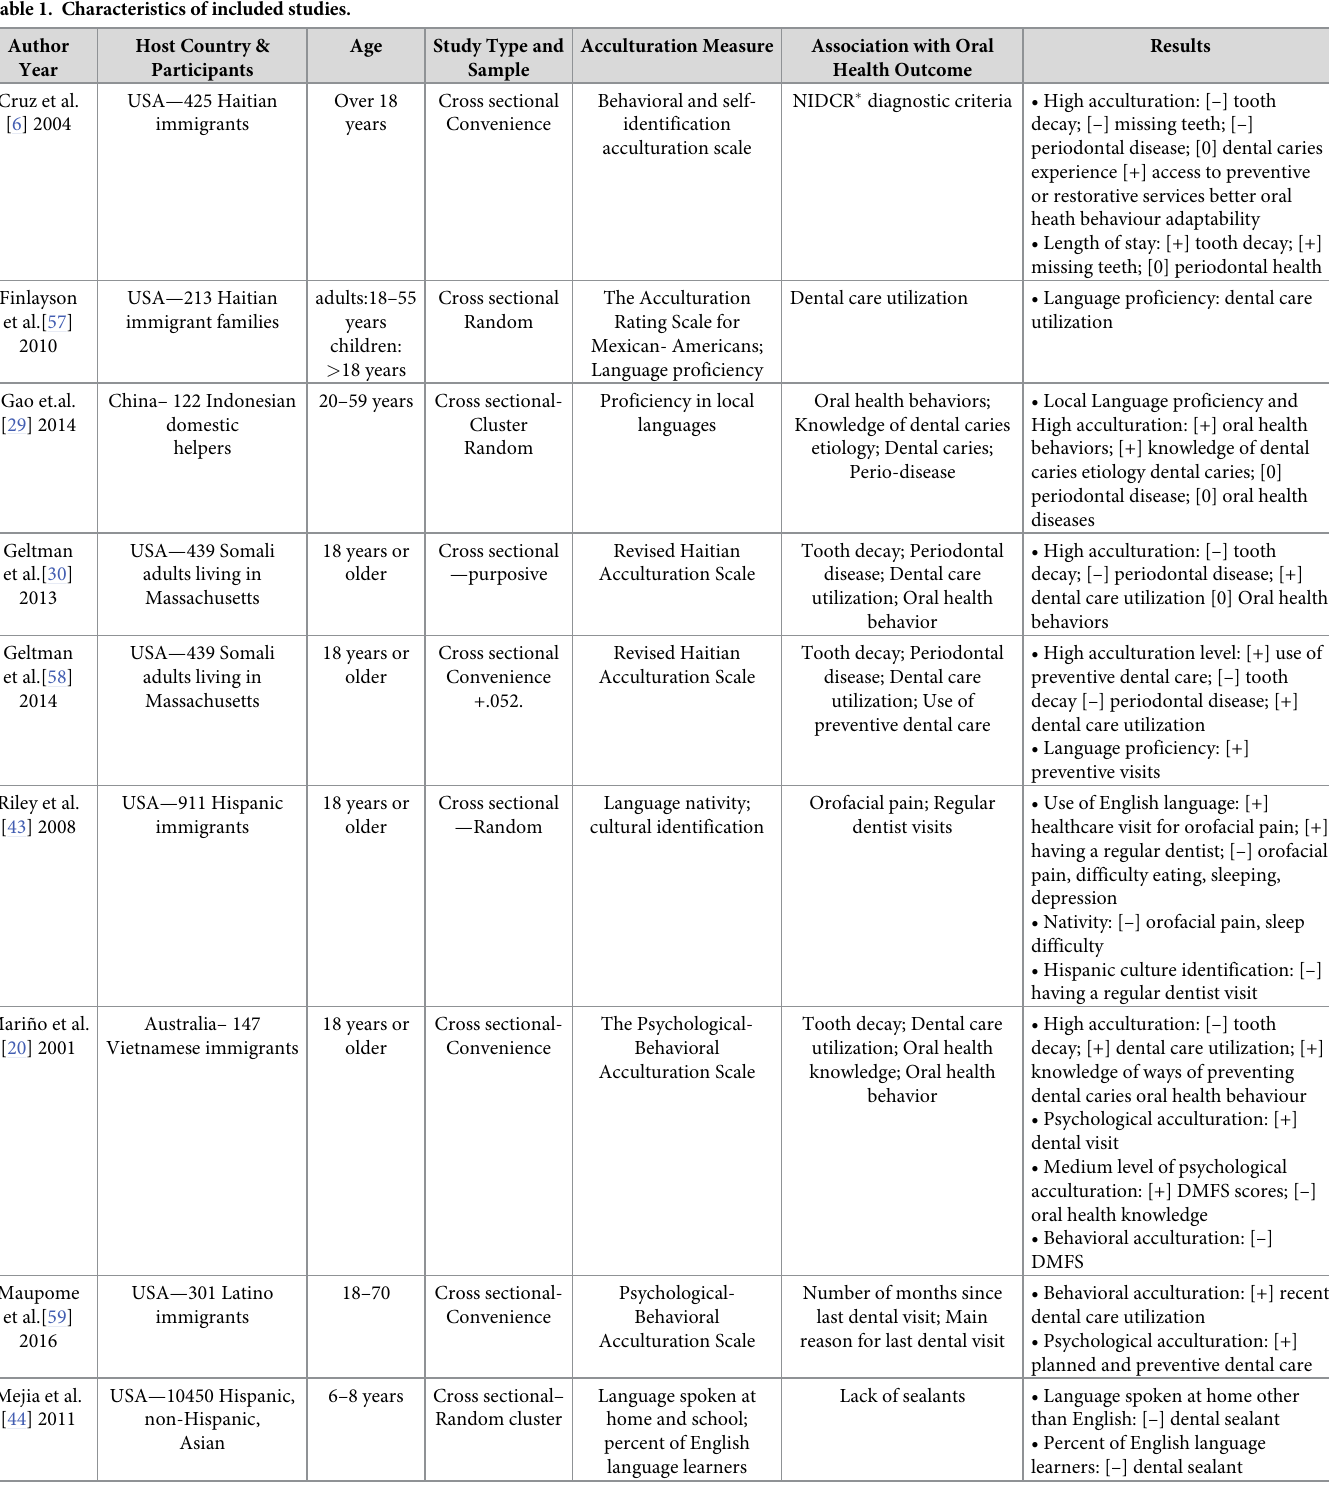
Table 1. Characteristics of included